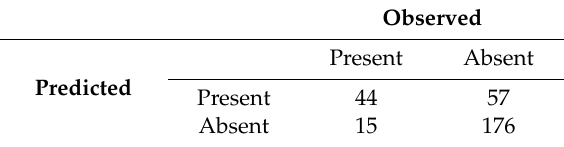
Table A14. Coarse substrate SR-LOO CV error matrix with threshold of occurrence set to 0.27.